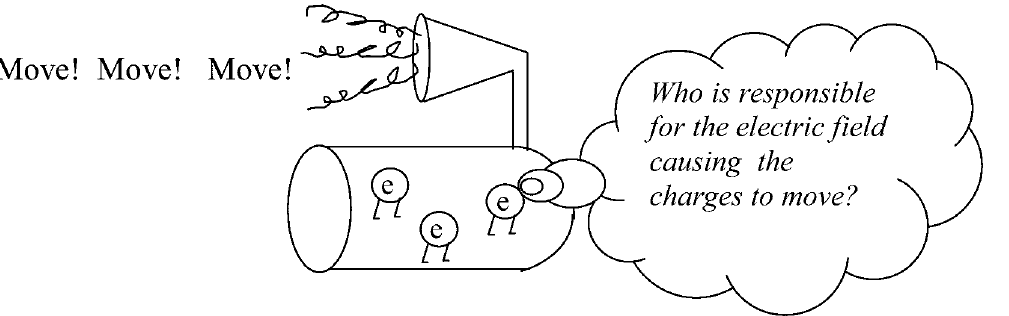
TABLE IV. The “The Story of the minimodule”—an abstract describing the future plan of the lessons as presented by the “From electrostatics to currents” group. The story of the minimodule “From electrostatics to currents” Possible place in the teaching sequence: One out of three